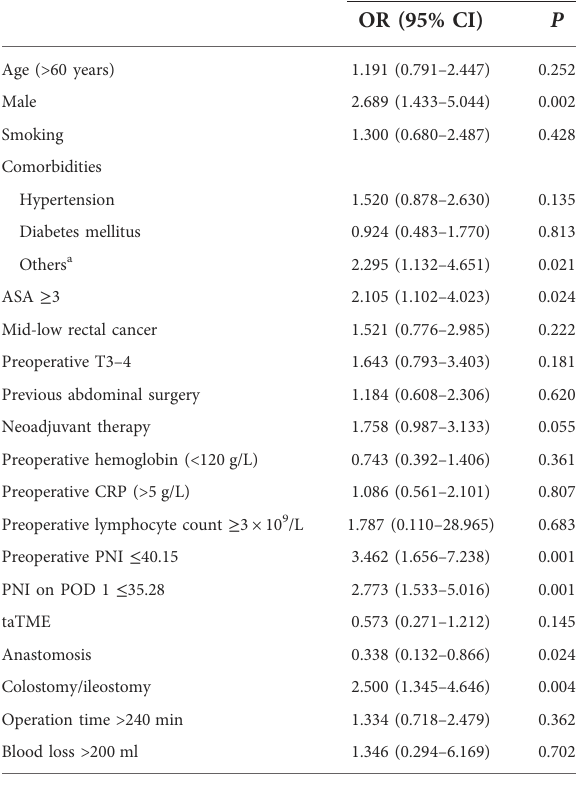
TABLE 3 The association between PNI and the occurrence of surgical